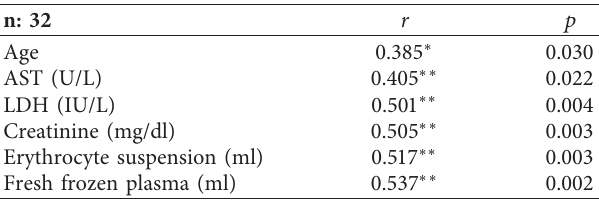
Table 3: Spearman’s correlation analysis of factors affecting the length of stay in the ICU.